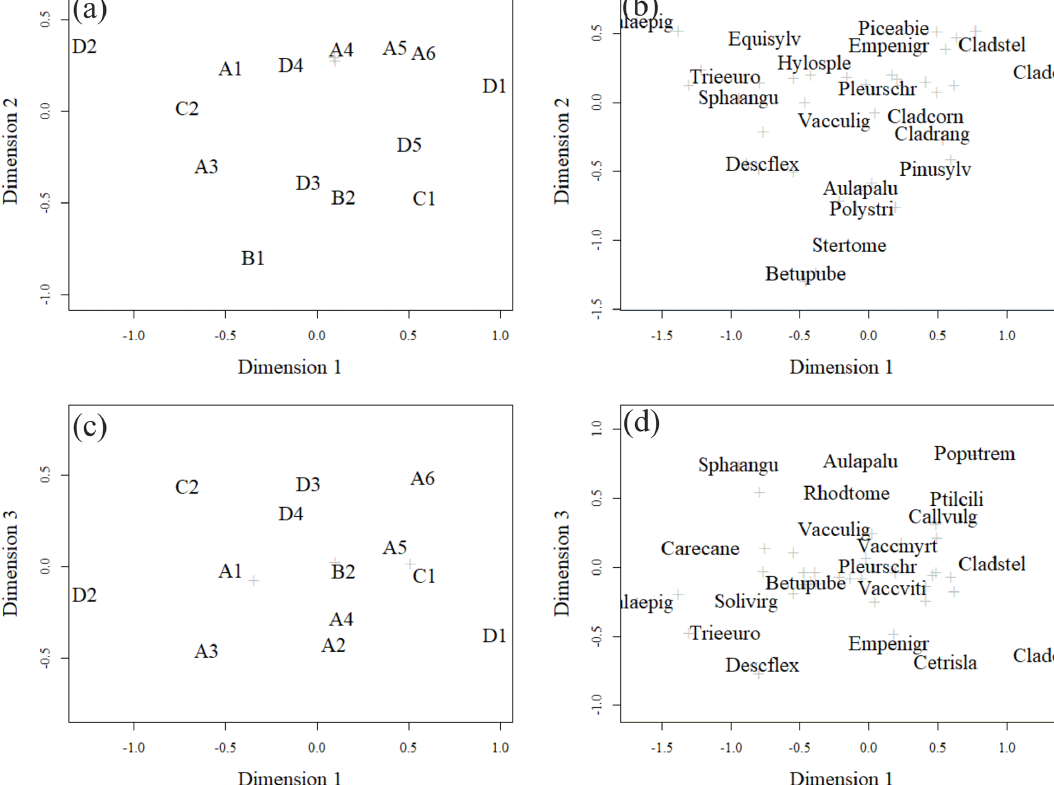
foliar N and P contents were not reflected in the